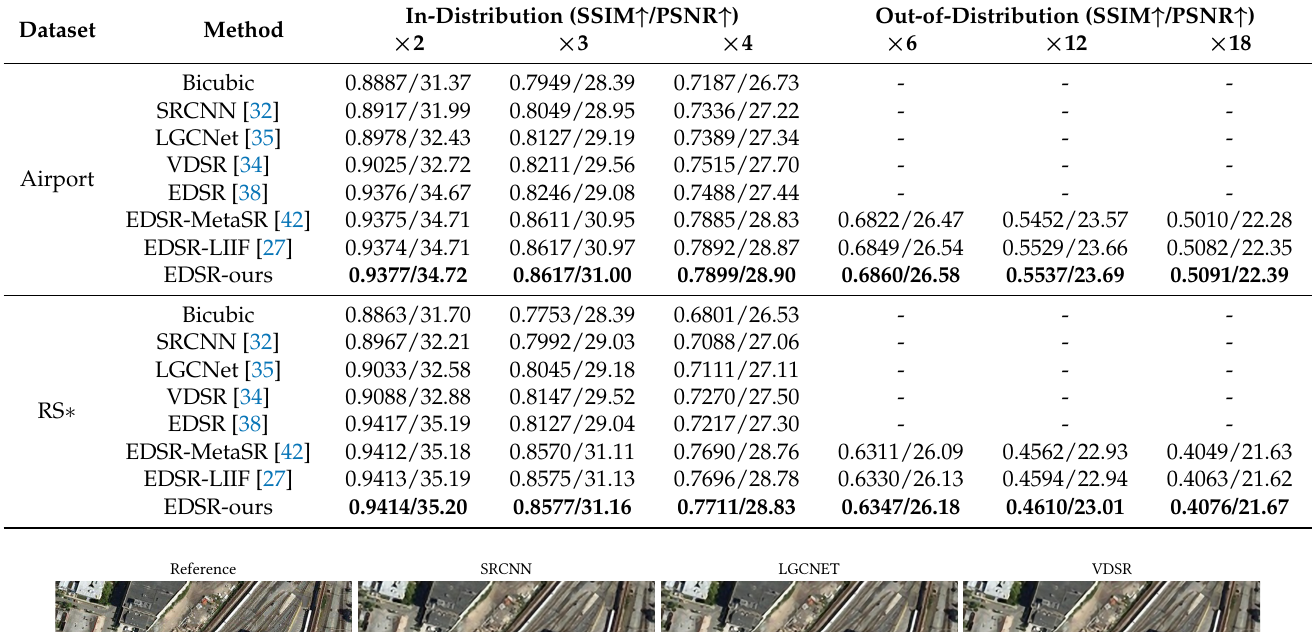
Table 1. Quantitative comparisons between the AID test set (PSNR (dB) and SSIM). (RS ∗ : railway station, the bold in table is the highest value).